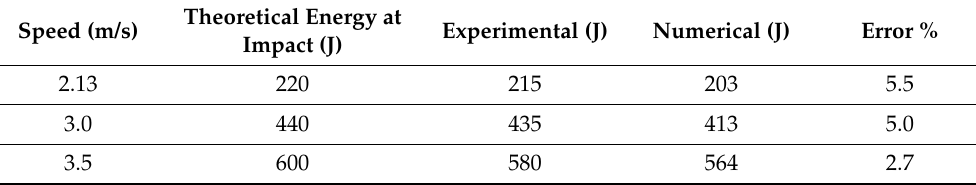
Figure 12. Comparison of the energy-speed curves between experimental test and numerical model. Table 3. Predicted and experimental results for composite material reinforced closed top hat. Speed